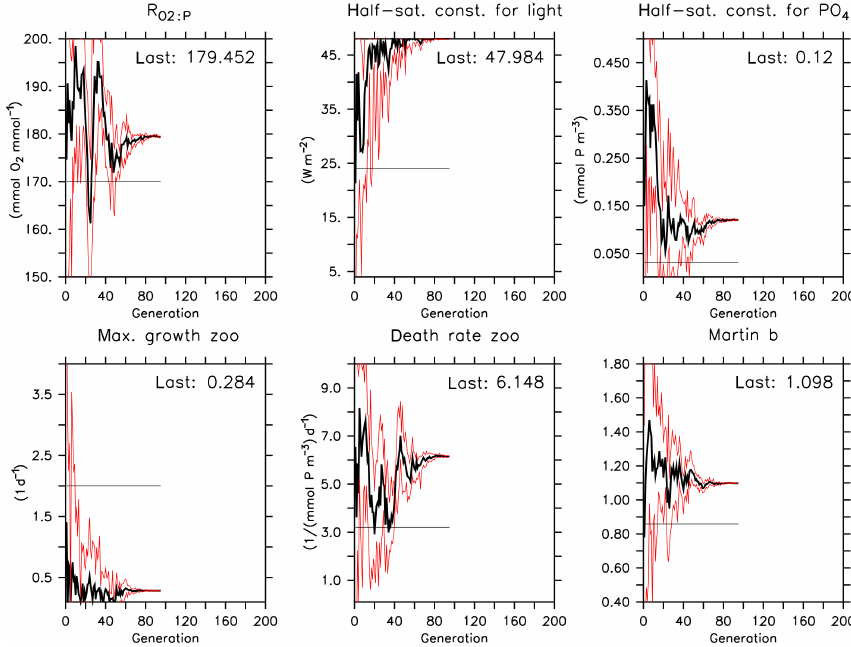
Figure 8. As Fig. 3, but for optimization OBS-WIDE. The optimization finished at generation 95.